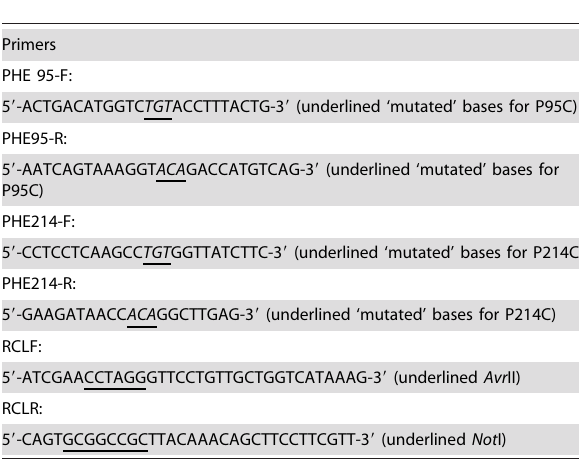
Table 2. Primers for plasmid pPIC9K-proRCLCYS